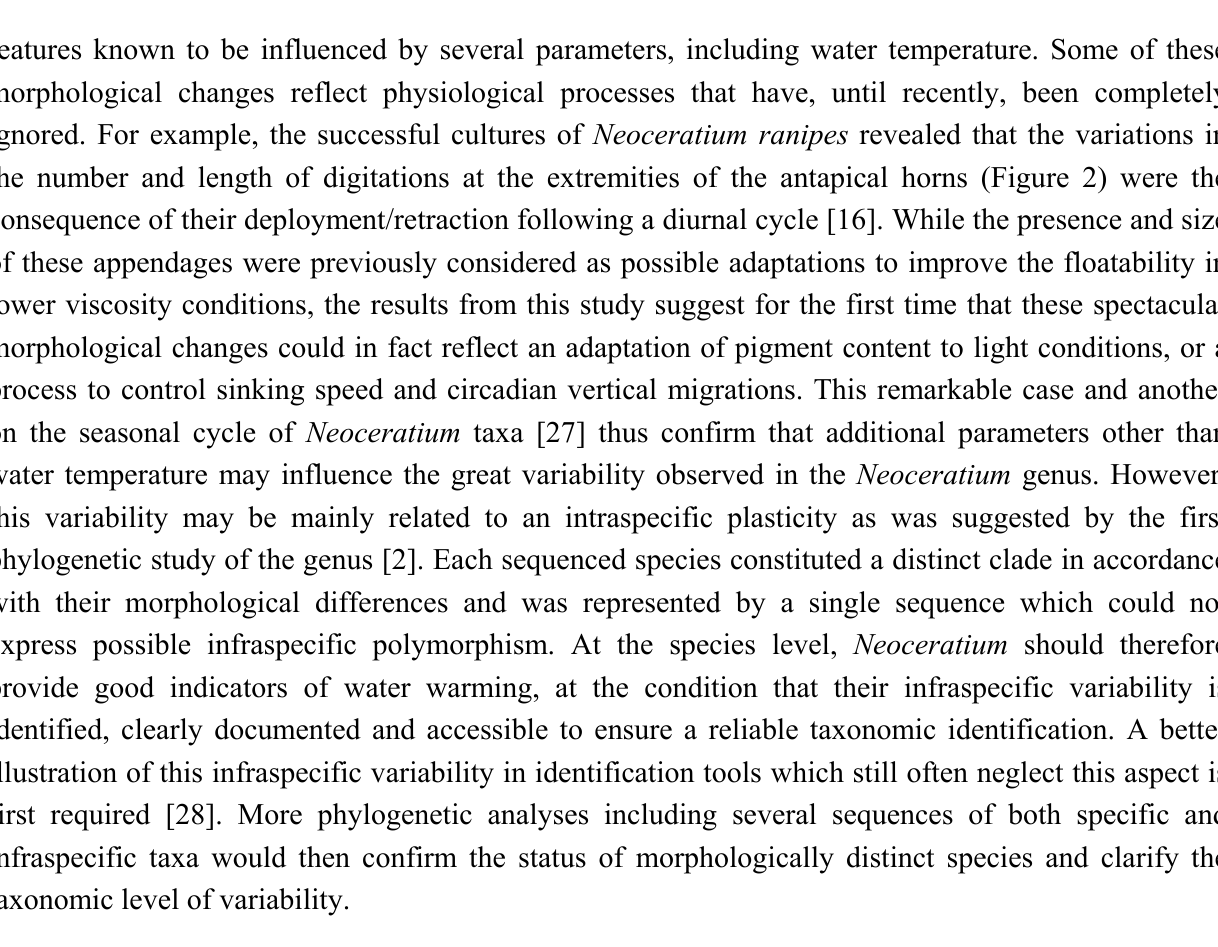
Figure 2. Variations of digitation configuration at the extremities of the antapical horns in Neoceratium ranipes . One dark period cell without digitations as opposed to three light period cells exhibiting daily-formed digitations. Bar scale 50 μ m. Lugol